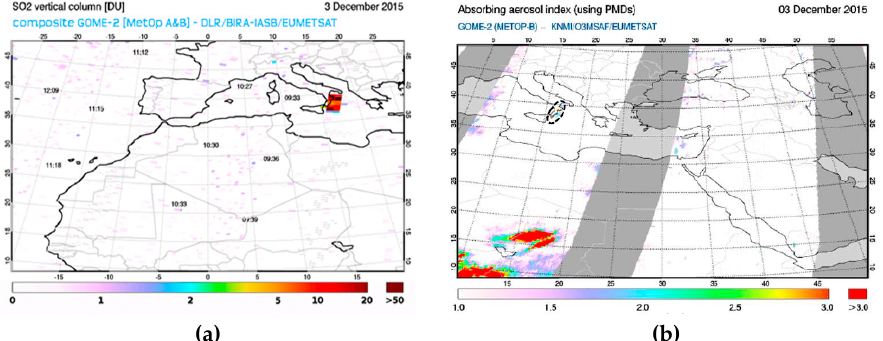
Figure 6. Global Ozone Monitoring Experiment ‐ 2 (GOME ‐ 2) products of 3 December 2015 made available by Support to Aviation Control Service (SACS) (http://sacs.aeronomie.be/). ( a ) SO 2 vertical column; ( b ) absorbing aerosol index map.